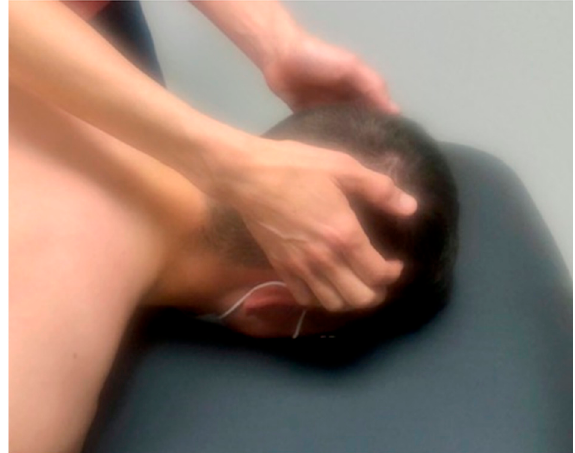
Figure 2. Circular movement on the scalp.